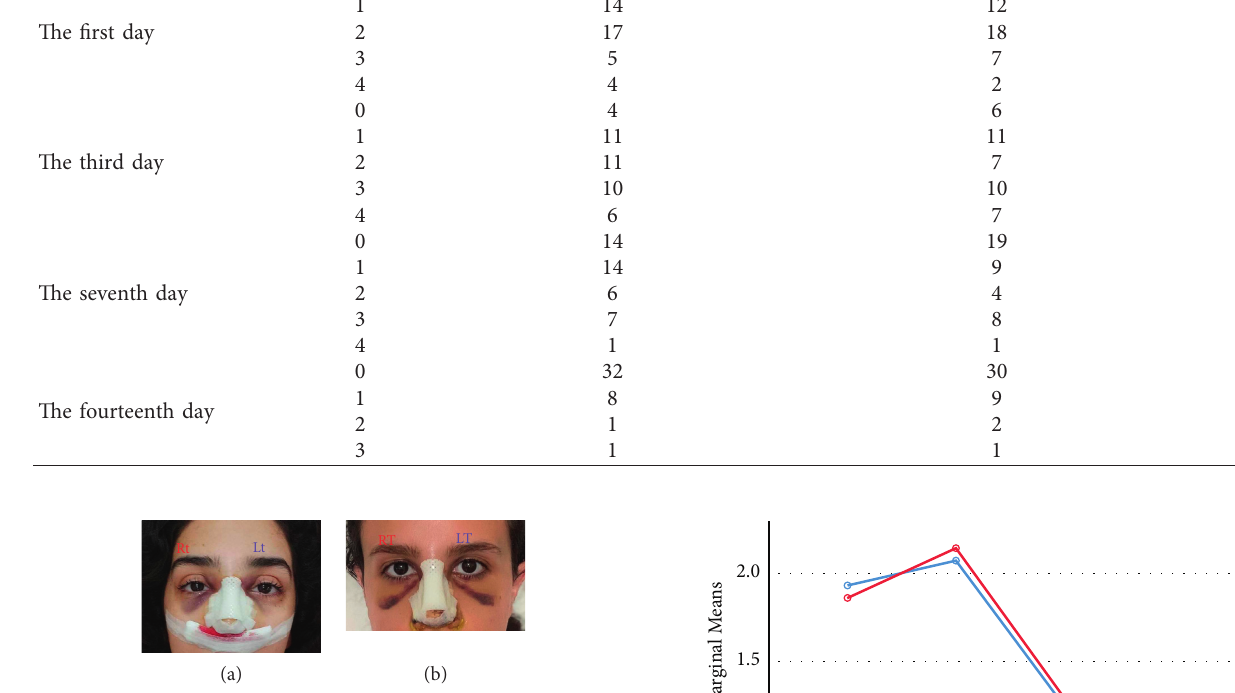
Figure 1: Example of grading assessment for two patients A and B.